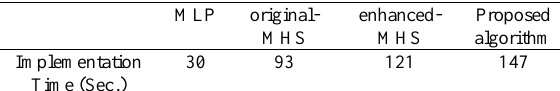
Table 2.The implementation time of the algorithms